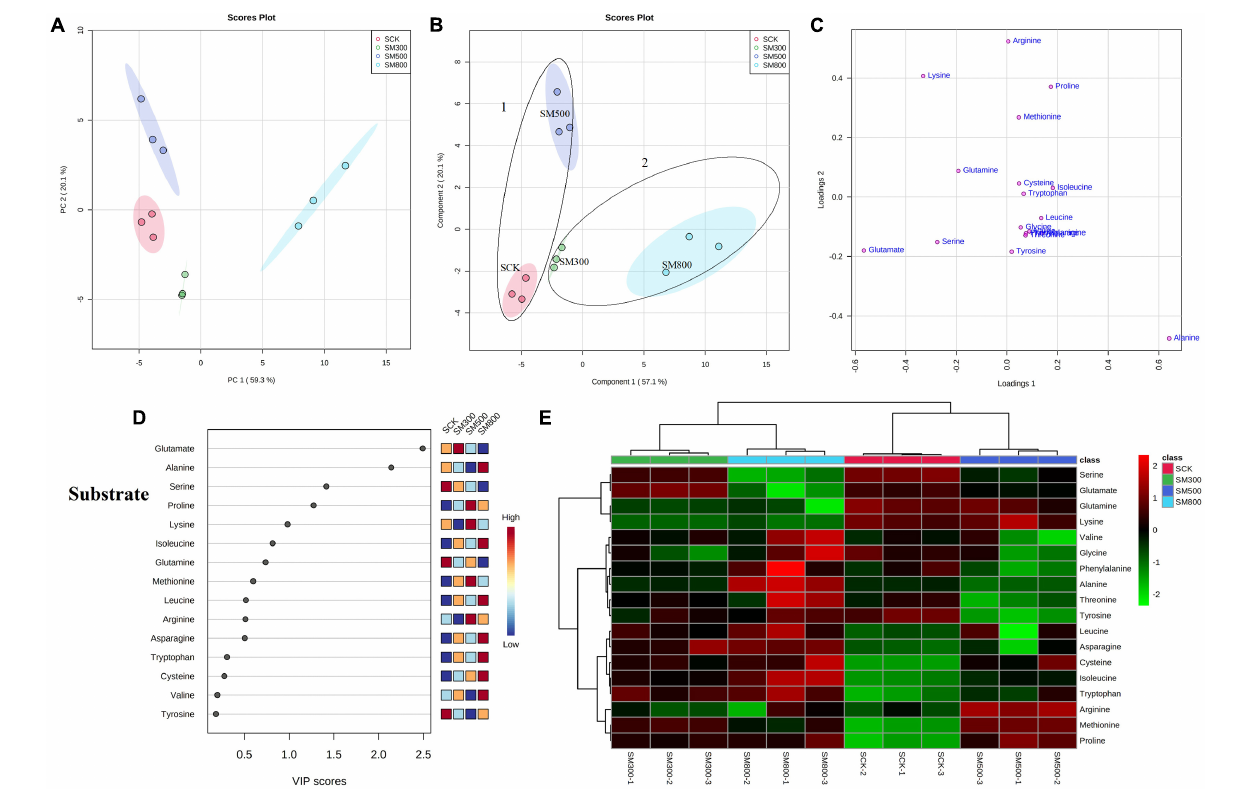
FIGURE 3 | Statistical analyses of bioactive metabolites in substrate-grown Chinese chive treated with methyl jasmonate (MeJA). (A) An unsupervised principal component analysis (PCA) score plot of amino acid metabolites. (B) A partial least squares discriminant analysis (PLS-DA) score plot of amino acid metabolites. (C) PLS-DA score plots loaded with different amino acid metabolites. (D) VIP scores of amino acid metabolites in PLS-DA. The scores from low to high determine the importance of variables. The colored boxes on the right show the relative concentration of each metabolite from low (blue) to high (red). (E) Heat map of amino acid concentrations. The colored areas correspond to the concentrations of different amino acids from low (green) to high (red) in groups treated with different concentrations of MeJA. Each row represents an amino acid, and each column represents a